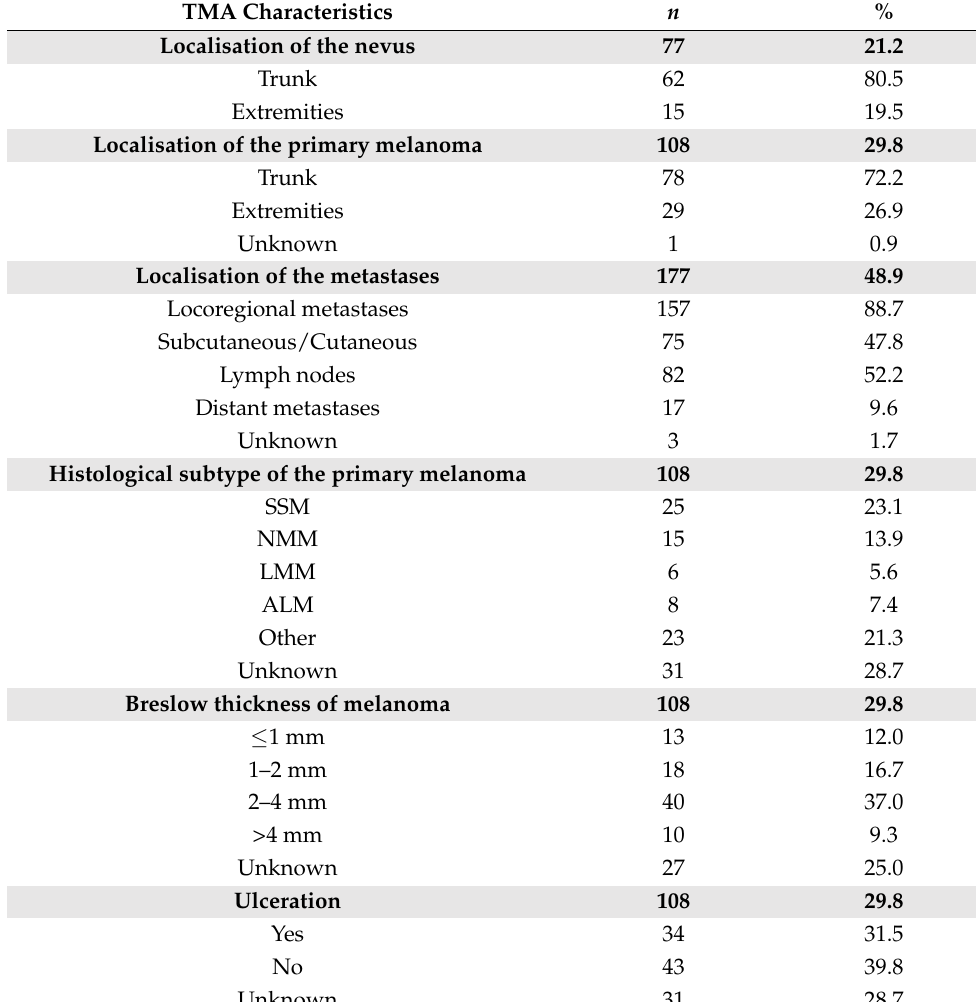
Table 1. Detailed overview of the TMA